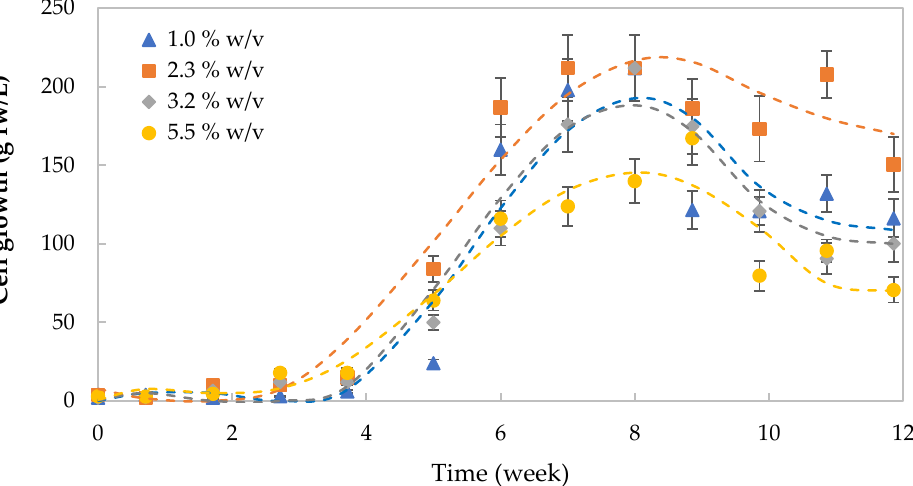
Figure 3. Growth kinetics expressed as dry weight (g/L) of Taraxacum officinale cell cultures main- tained in different growth media containing 1.0%, 2.3%, 3.2%, and 5.5% ( w / v ) sucrose for 12 weeks. Each value is the mean of three replicates.